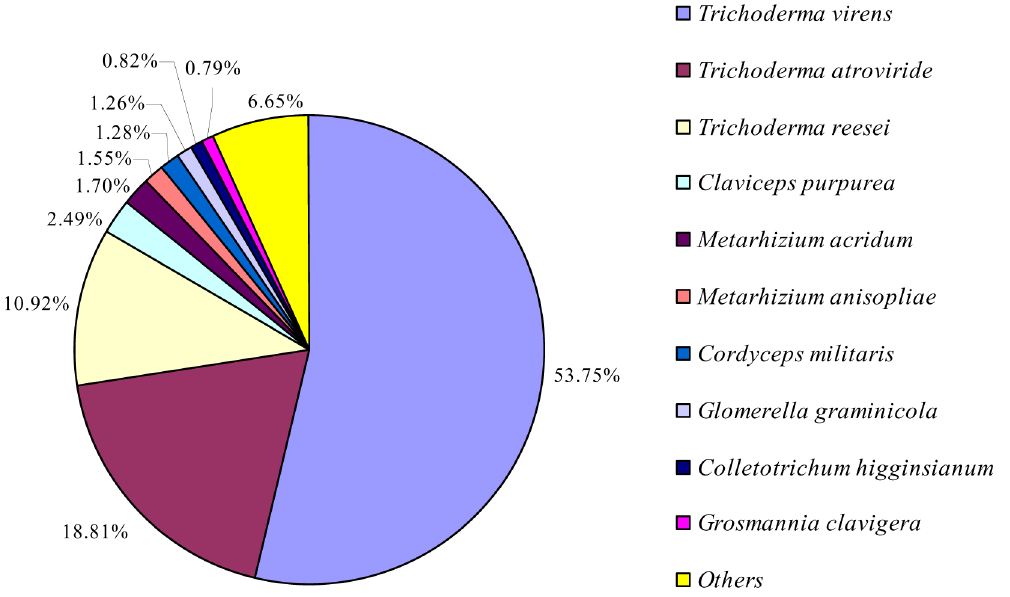
Figure 2. Species distribution of the BLASTX results. Unigenes were searched using BLASTX against the nr protein database with a cutoff E value , 10 2 5 . Different colors represent different species. We used the first hit of each unigene for analysis.